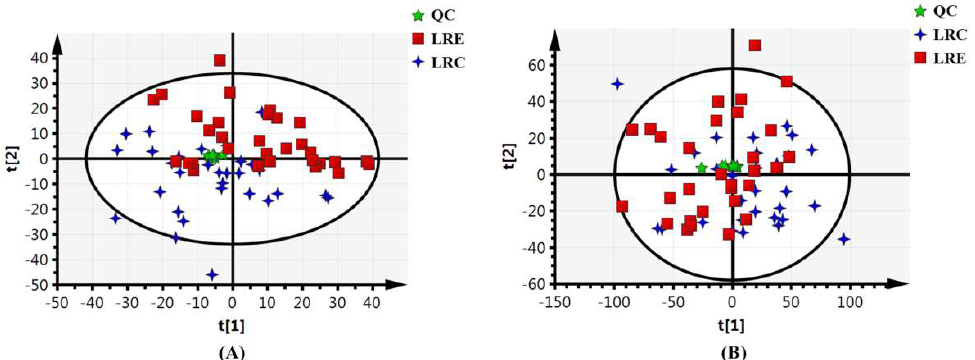
Figure 1. Scores plot from the principal component analysis of the overall data set containing all of the QC samples (9 replicates) ( A ) in the positive ionization mode; ( B ) in the negative ionization mode. Blue crosses represent LRC group. Red squares represent LRE group. Green asterisks represent QC samples. Their spatial distribution reveals the variations of the metabolic profiles. The closer the QC samples cluster on the score plot, the more stable the metabolomics analysis. All of the replicates of the QC samples within the analytical run are tightly clustered in the center, indicating that the metabolomics analysis in this study is stable and the differences between the samples are meaningful. QC, quality control; LRC, centenarians in the longevous region; LRE, elderly people aged 60–70 years in the longevous region.